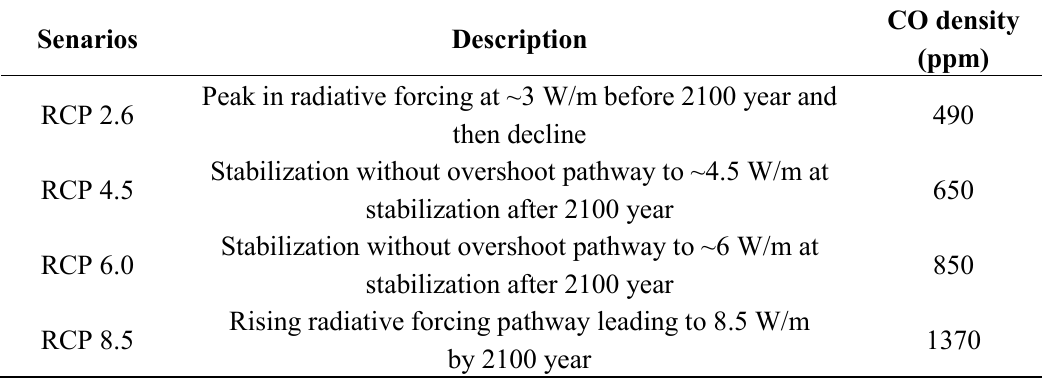
Table 2. RCP(Representative concentration pathways) scenario